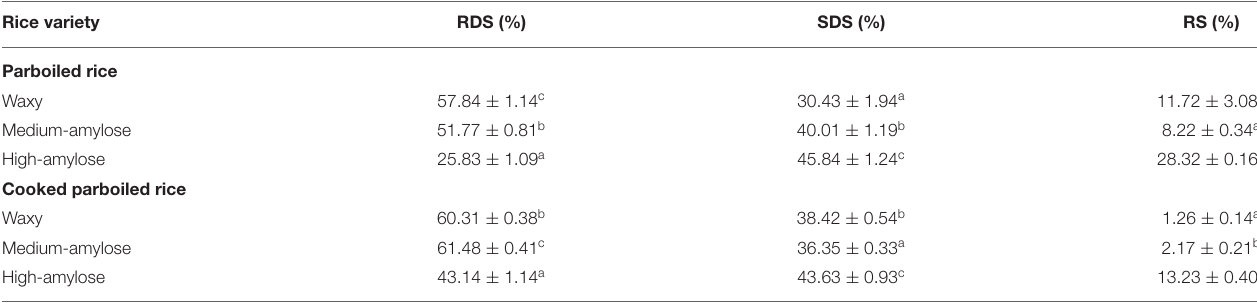
TABLE 5 | Rapidly digestible starch (RDS), slowly digestible starch (SDS), and resistant starch (RS) contents of starch in parboiled and cooked parboiled black rice † . Rice